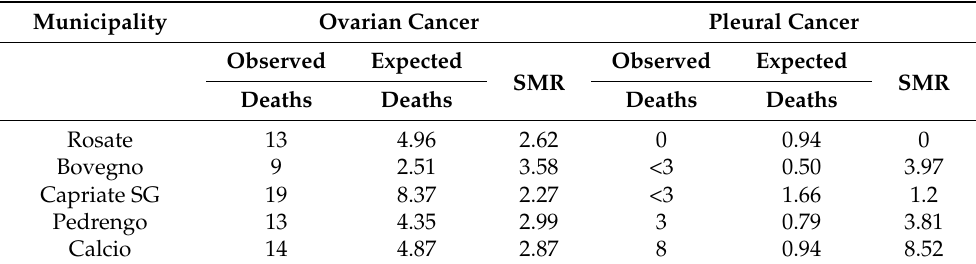
Table 1. Observed and expected deaths, and standardized mortality ratios (SMR) for ovarian cancer and pleural cancer. Municipalities with SMR for ovarian cancer above the regional average ( p < 0.001). Lombardy Region, 2000–2018.